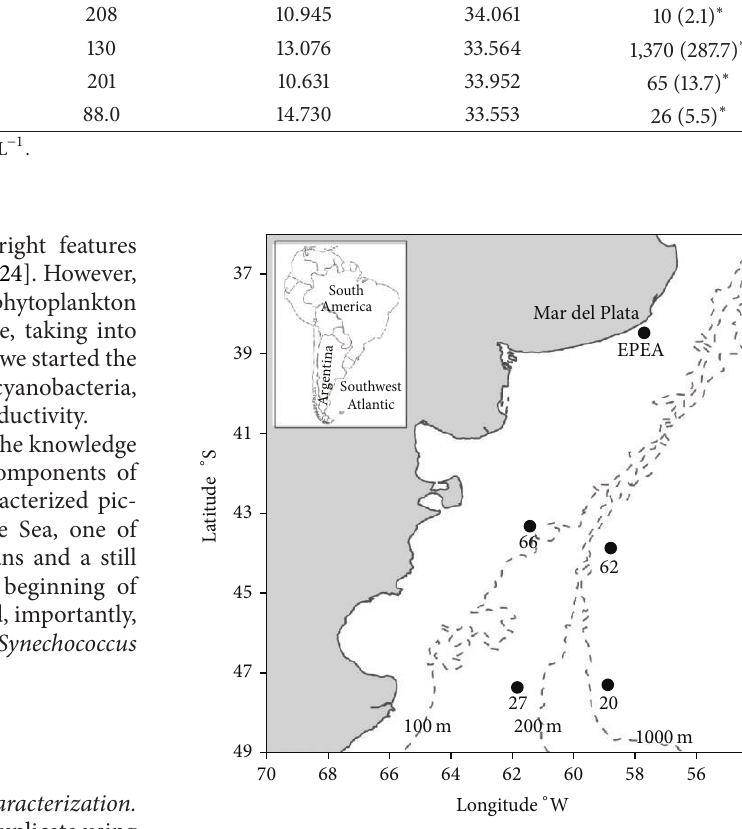
Figure 1: Map showing the location of sampling stations at the Argentine Sea (southwest Atlantic Ocean). Permanent coastal sta- tion (EPEA) and four stations (27 and 66 (continental shelf) and 20 and 62 (oceanic waters)) of the RV ARA “Puerto Deseado” cruise (PNUD ARG 02/018